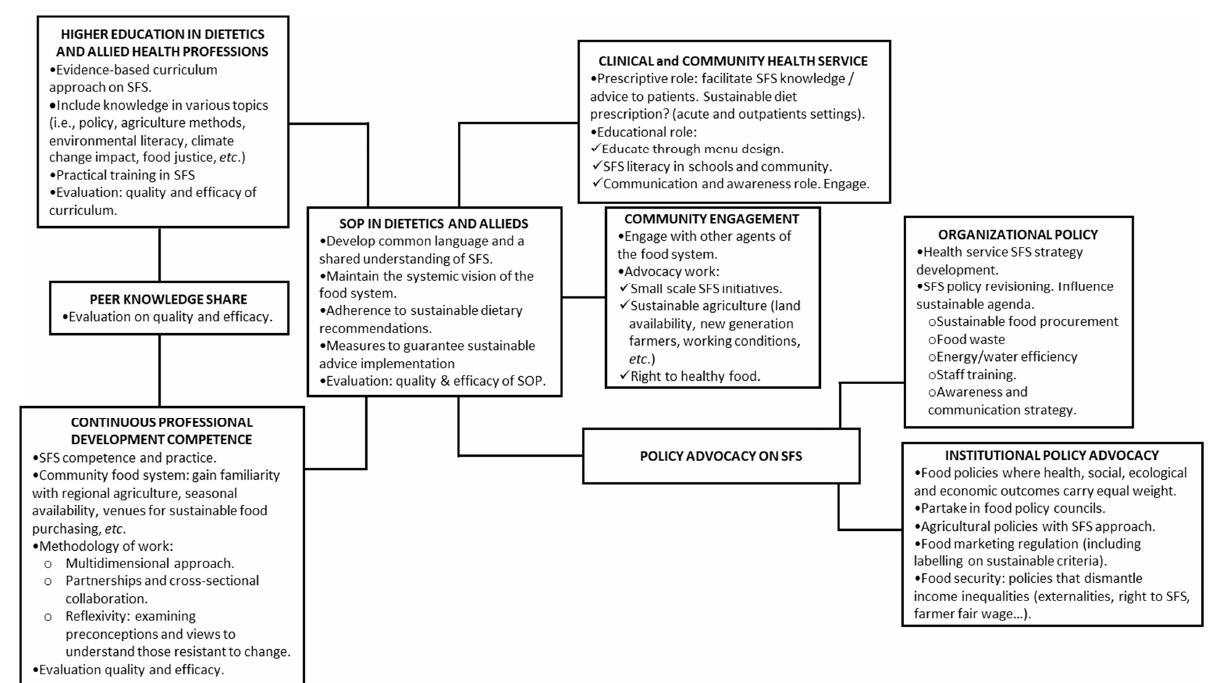
Figure 2. Theoretical framework visualizing the principal elements identified through the scoping review on sustainable diet promotion. Sustainable Food System (SFS).